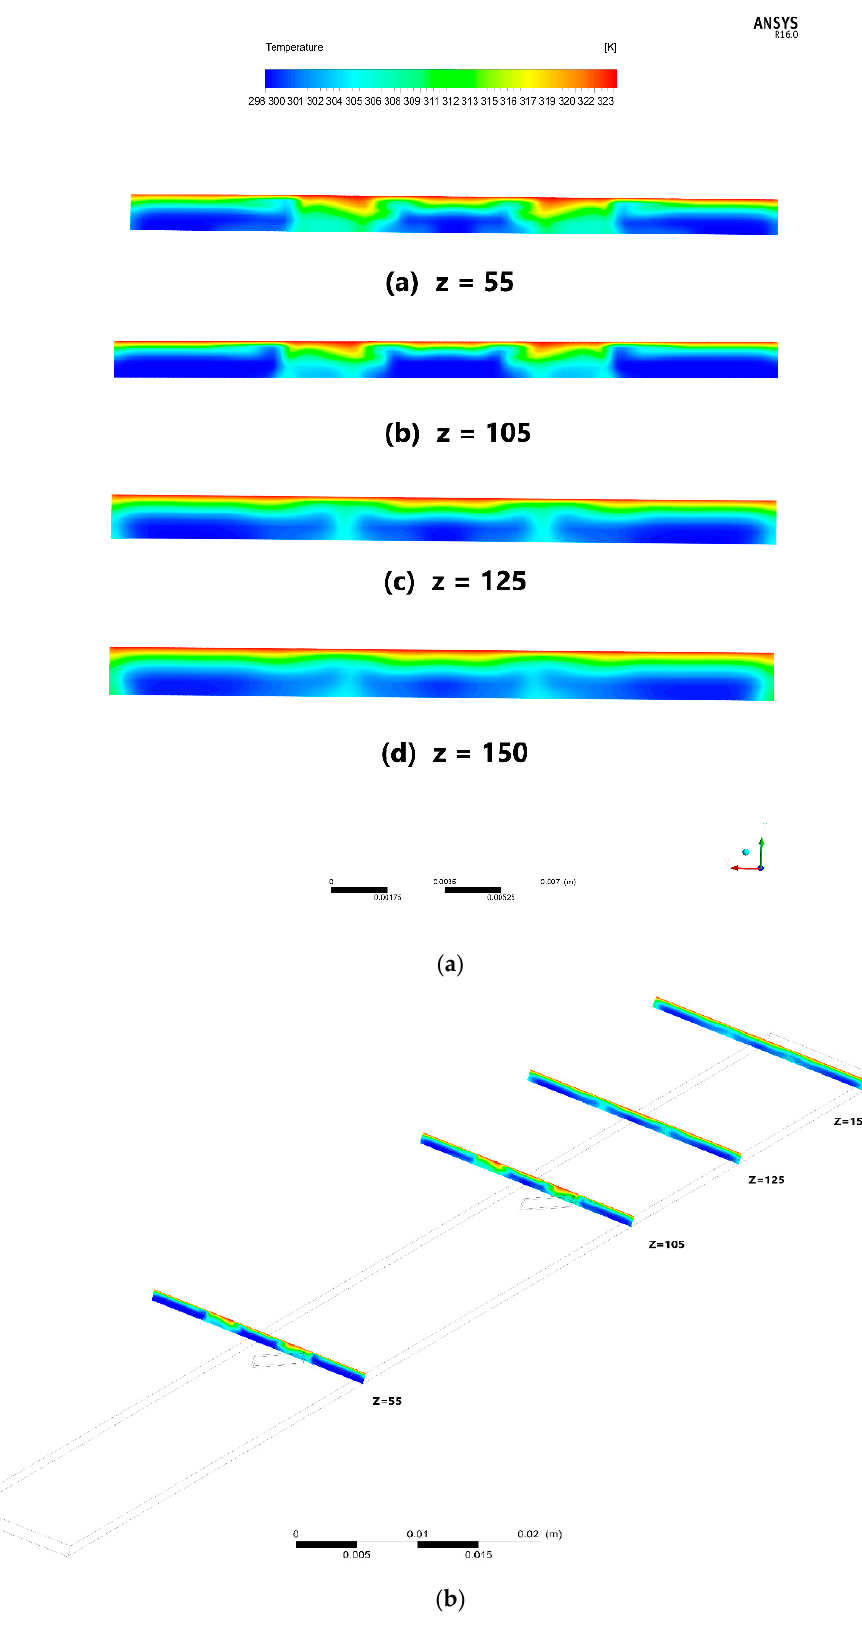
Figure 6. ( a ) Temperature distribution on di ff erent cross-sections along the stream-wise direction for A 1 configurations at Re = 800; ( b ) cross-sections positions along the